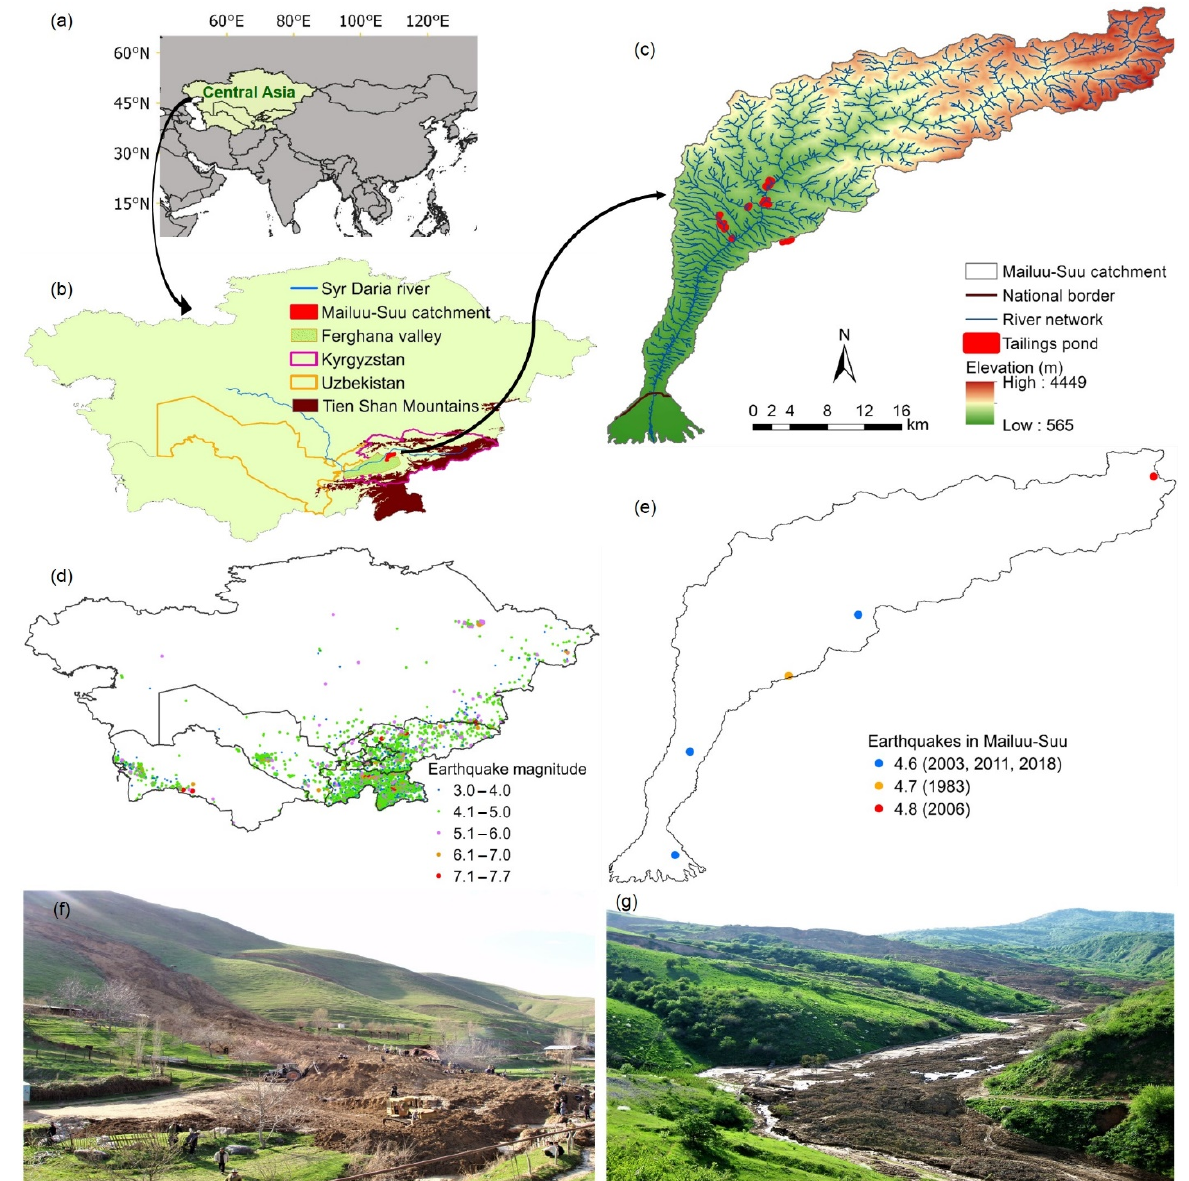
Figure 1. Maps of ( a ) the locality of Central Asia, ( b ) the important toponyms in the study area, ( c ) the distributions of tailings ponds and the elevation pattern of the Mailuu-Suu catchment, the localities of the recorded earthquake events in ( d ) Central Asia and ( e ) the Mailuu-Suu catchment between 1900 and 2020, and ( f , g ) the past landslide events in the Mailuu-Suu catchment.